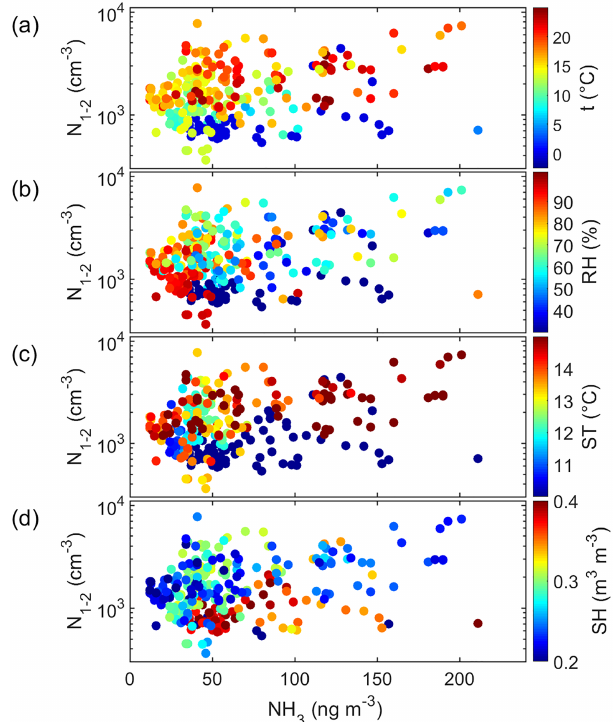
Figure 8. Cluster-mode aerosol number concentration ( N 1.1–2nm ) as a function of DMA concentration in the gas phase and color- coded with (a) air temperature ( t ), (b) air relative humidity (RH), (c) soil temperature (ST), and (d) soil humidity (SH). In all sub- plots, the black line shows the linear regression calculated by using all data, and in panel (b) the red line shows in addition the linear re- gression by using only those data that were measured at RH > 90%.